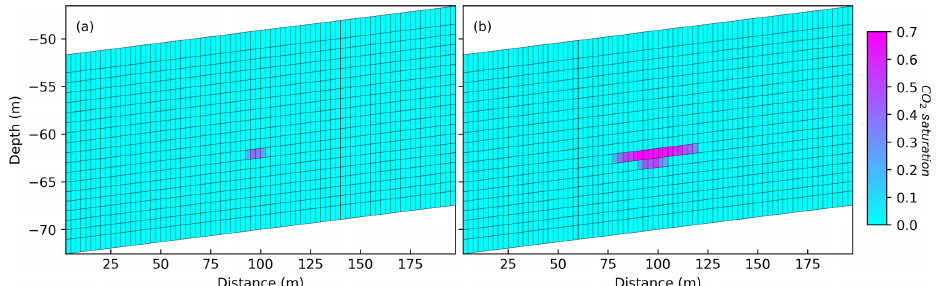
Figure 8. (a, b) Slice trough the 3D Eclipse grid at x = 92 . 5m, showing the simulated CO 2 cell saturation for (a) 1.7t and (b) 23t injected CO 2 respectively.